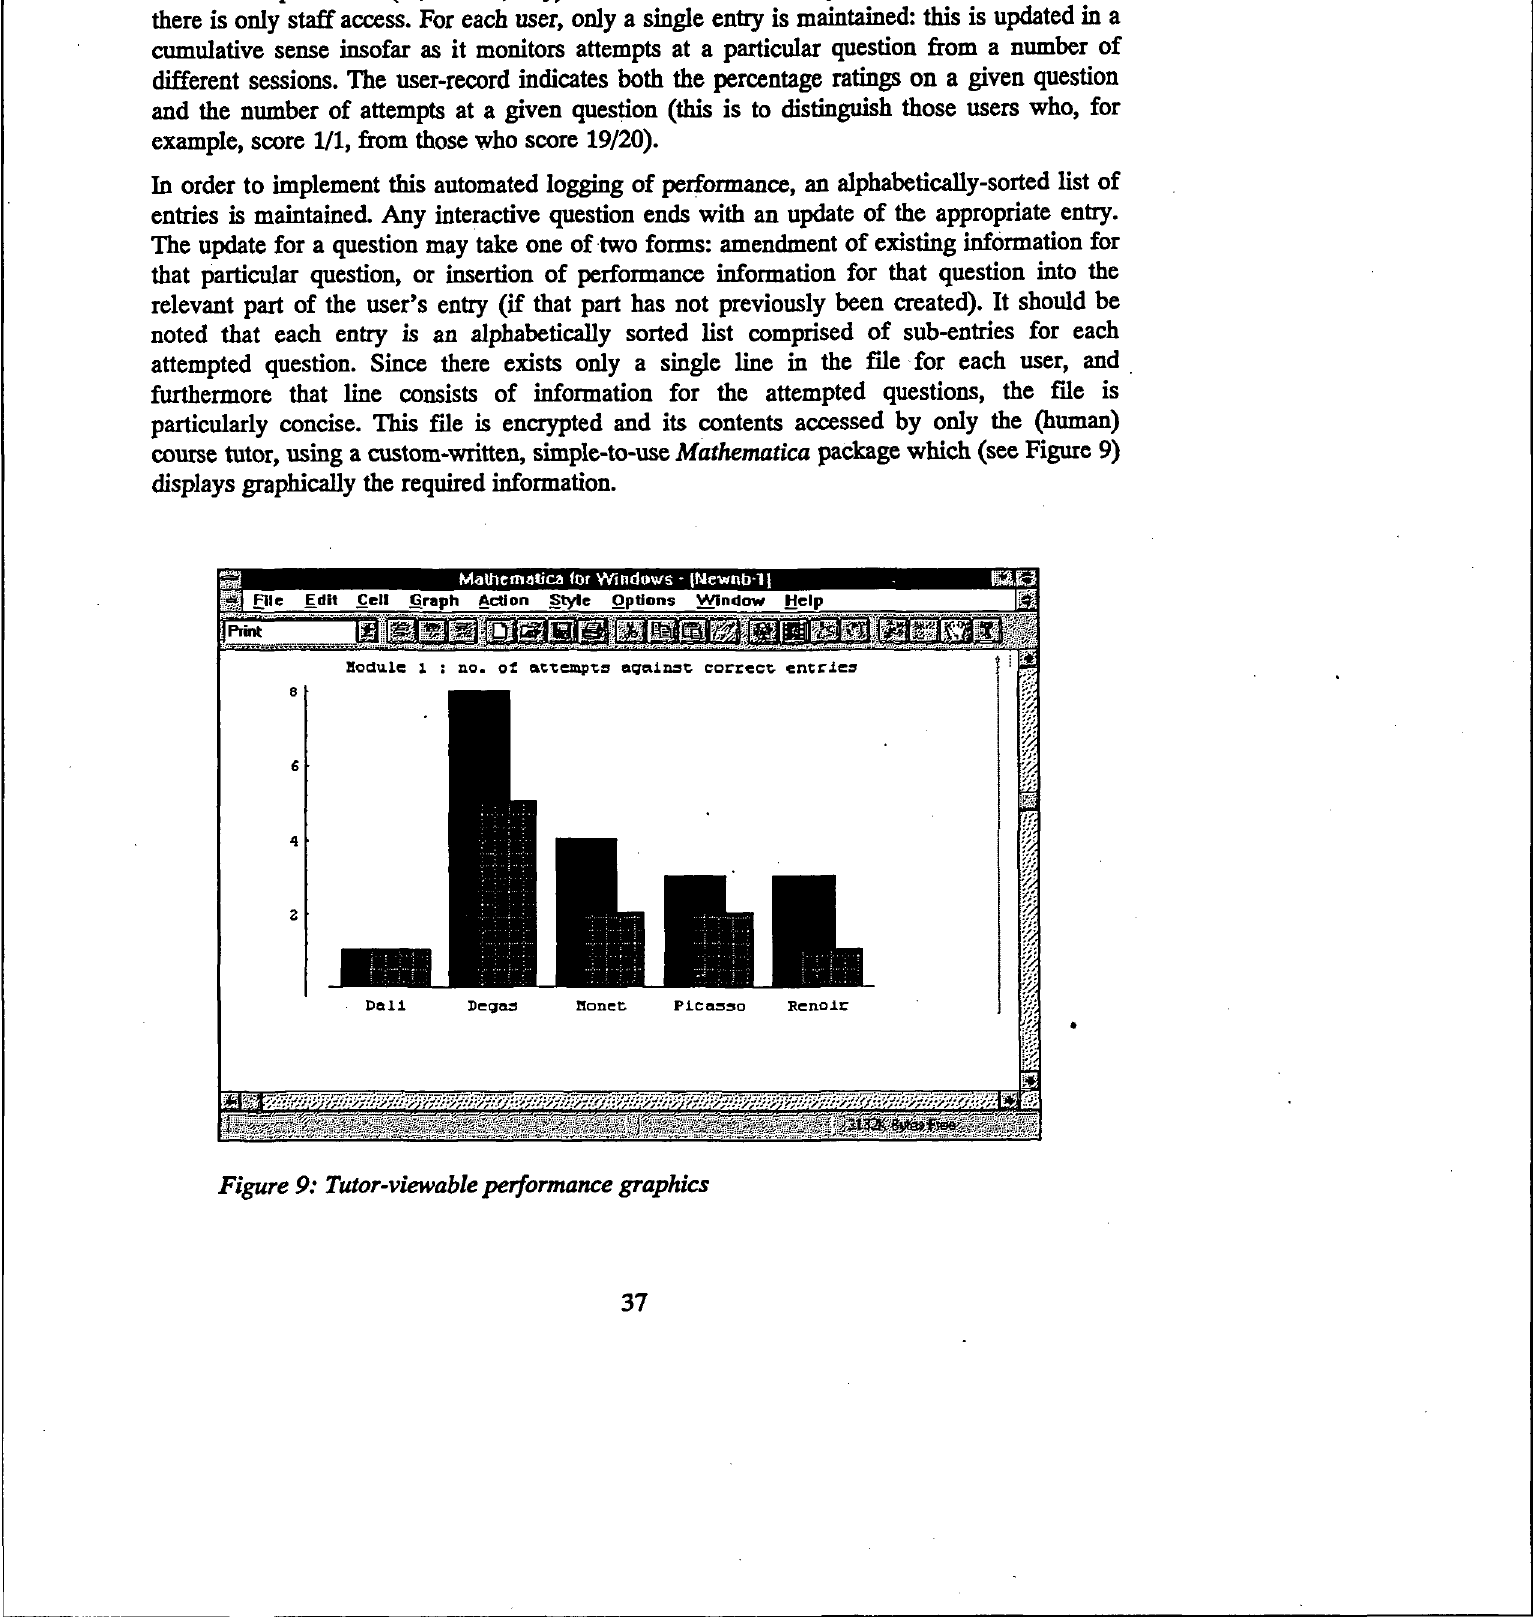
Figure 9: Tutor-viewable performance